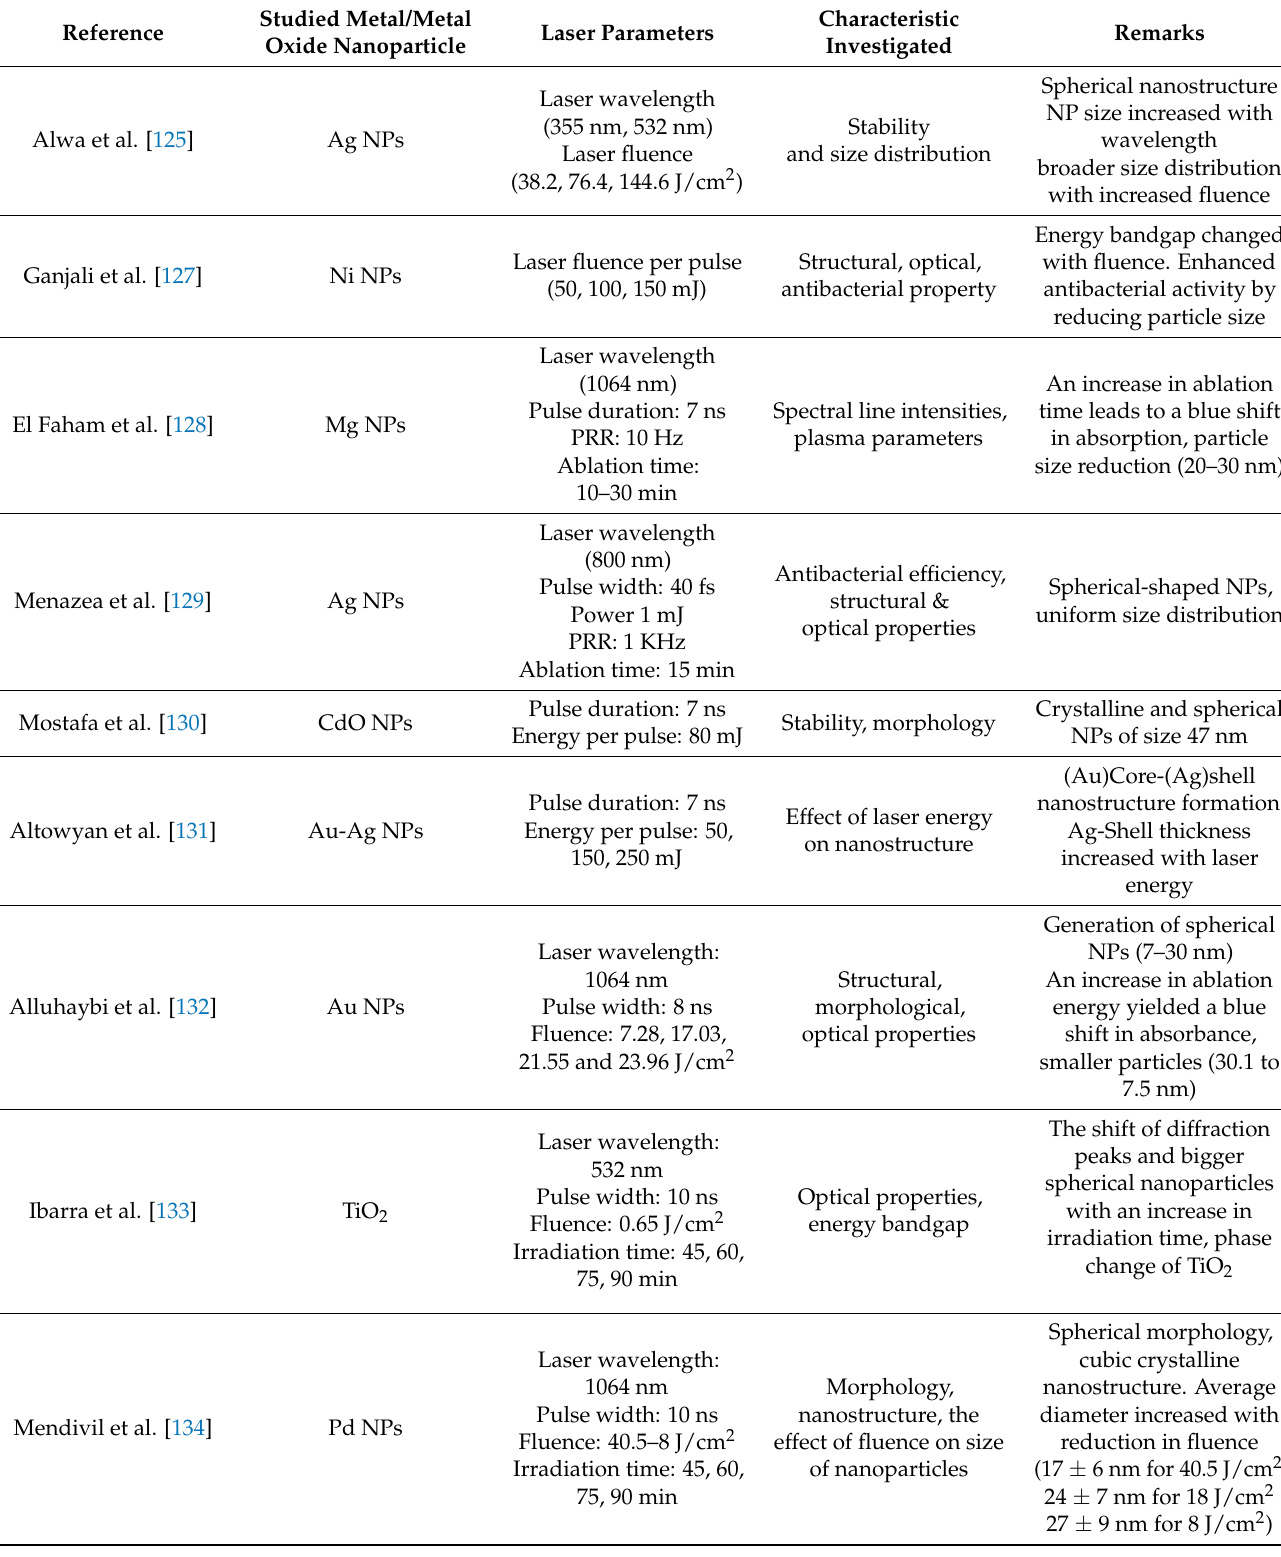
Table 2. State of the art studies on different metal nanoparticles showing the influence of laser parameters on the morphological, structural, and property changes in